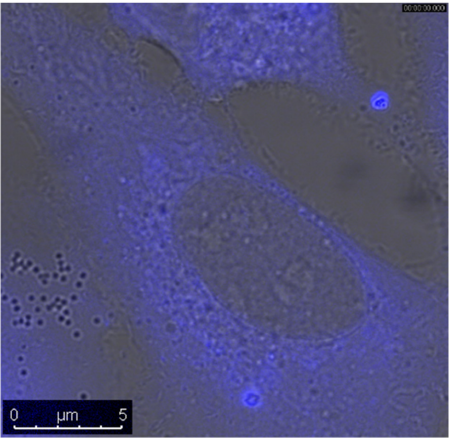
Figure 14. Uptake and localization of DAE-NH-Py ( c = 10 µ M) in live A549 cells. Cells were treated with DAE-NH-Py for 90 min at 37 ◦ C, the surplus of the dye washed with DMEM and subsequently observed by confocal microscopy, λ exc = 405 nm, λ em = 420–550 nm. Under the same instrument conditions, no auto-fluorescence of non-treated cells was